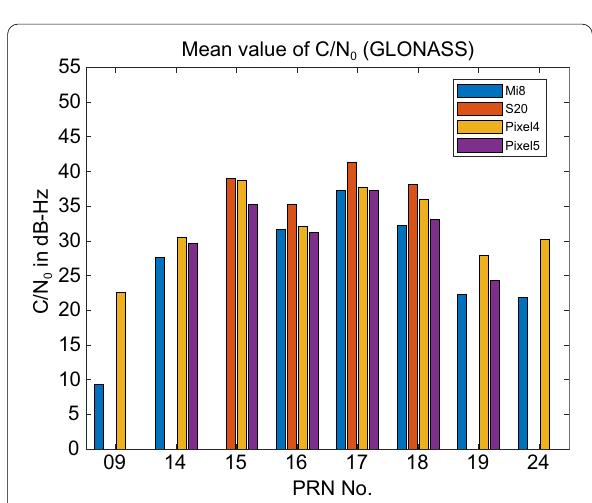
Fig. 6 Mean value of C/N 0 for all GLONASS